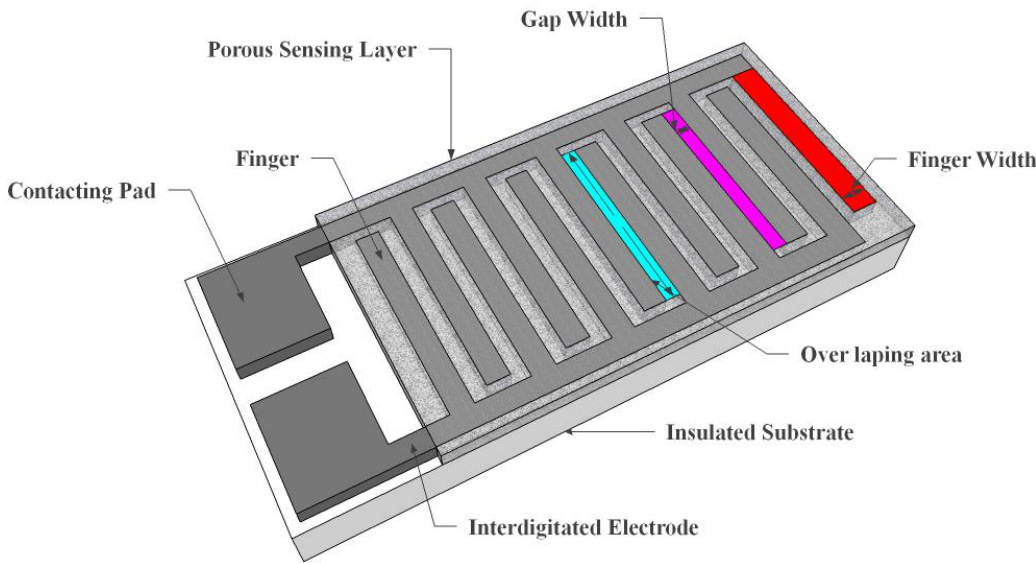
Figure 7. Sketch of a planar thick/thin film-based humidity sensor based on the interdigitated structure with the porous sensing element.